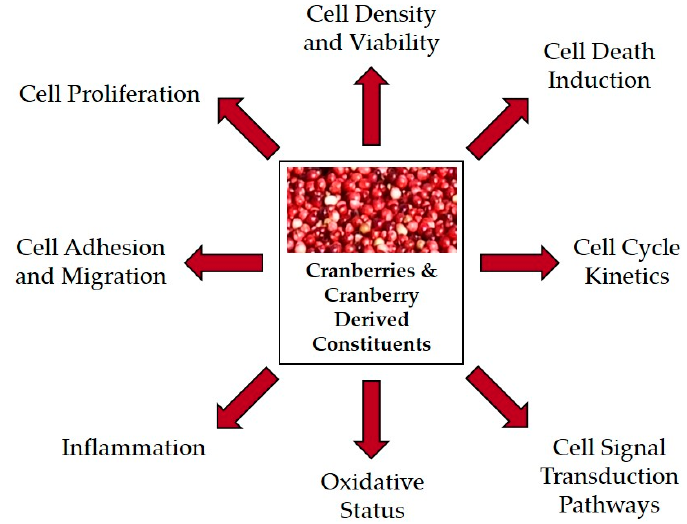
Figure 1. Cranberry and cranberry derived constituents target numerous mechanisms of cancer inhibition based on 34 preclinical studies.